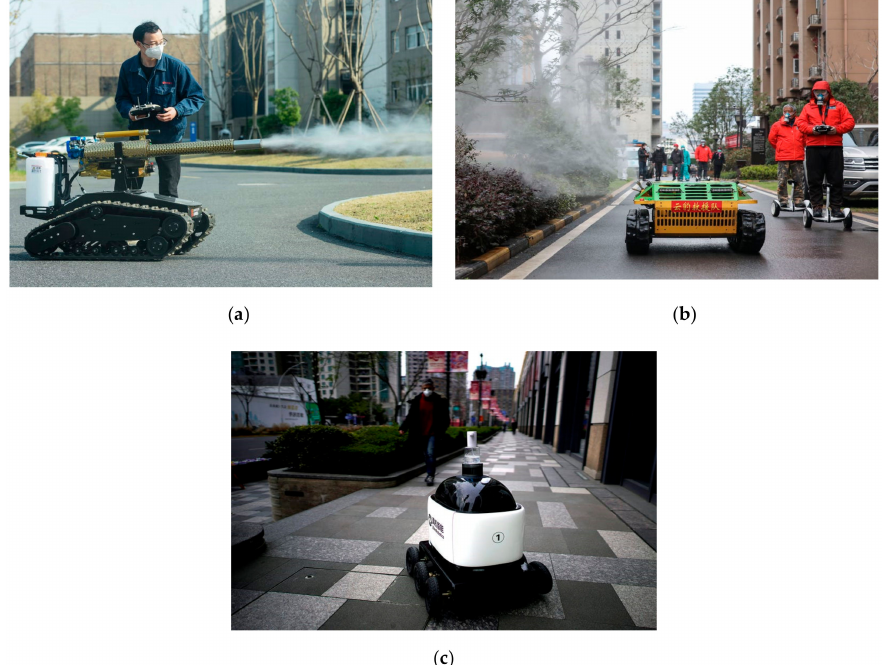
Figure 10. Spraying and sanitizing robots in residential areas of China [58]. ( a ) Remote control disinfecting mobile robot in Hangzhou, China. ( b ) Spraying robots to disinfect large residential areas in China. ( c ) A hand sanitizer-dispensing robot in